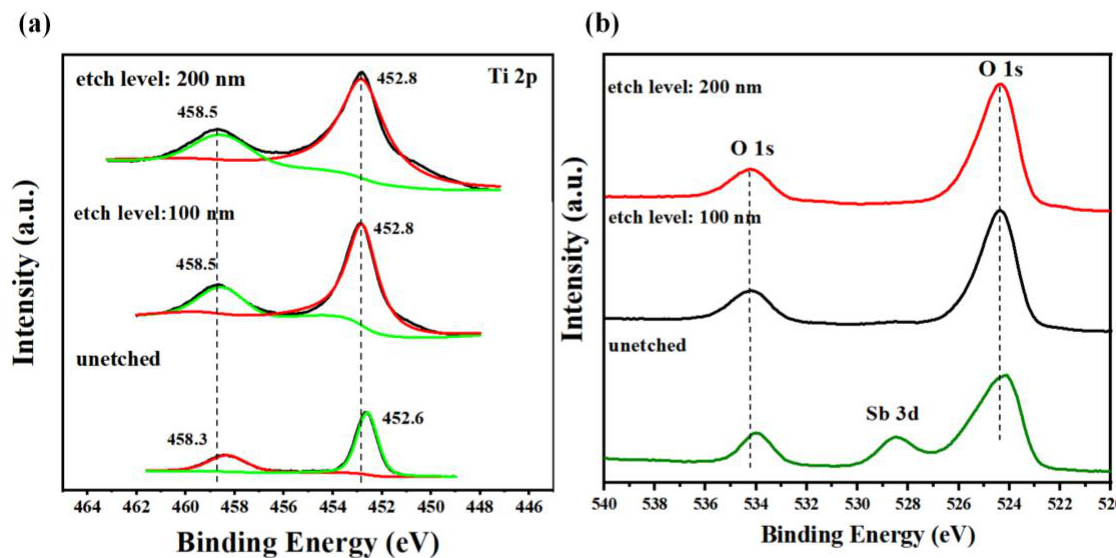
Figure 3. Fine XPS spectra of 2D Sb (4 mg)/TiO 2 NRAs with different etching depths. ( a ) Ti 2p. ( b ) Sb 3d and O 1s. TNRAs: TiO 2 nanorod arrays.